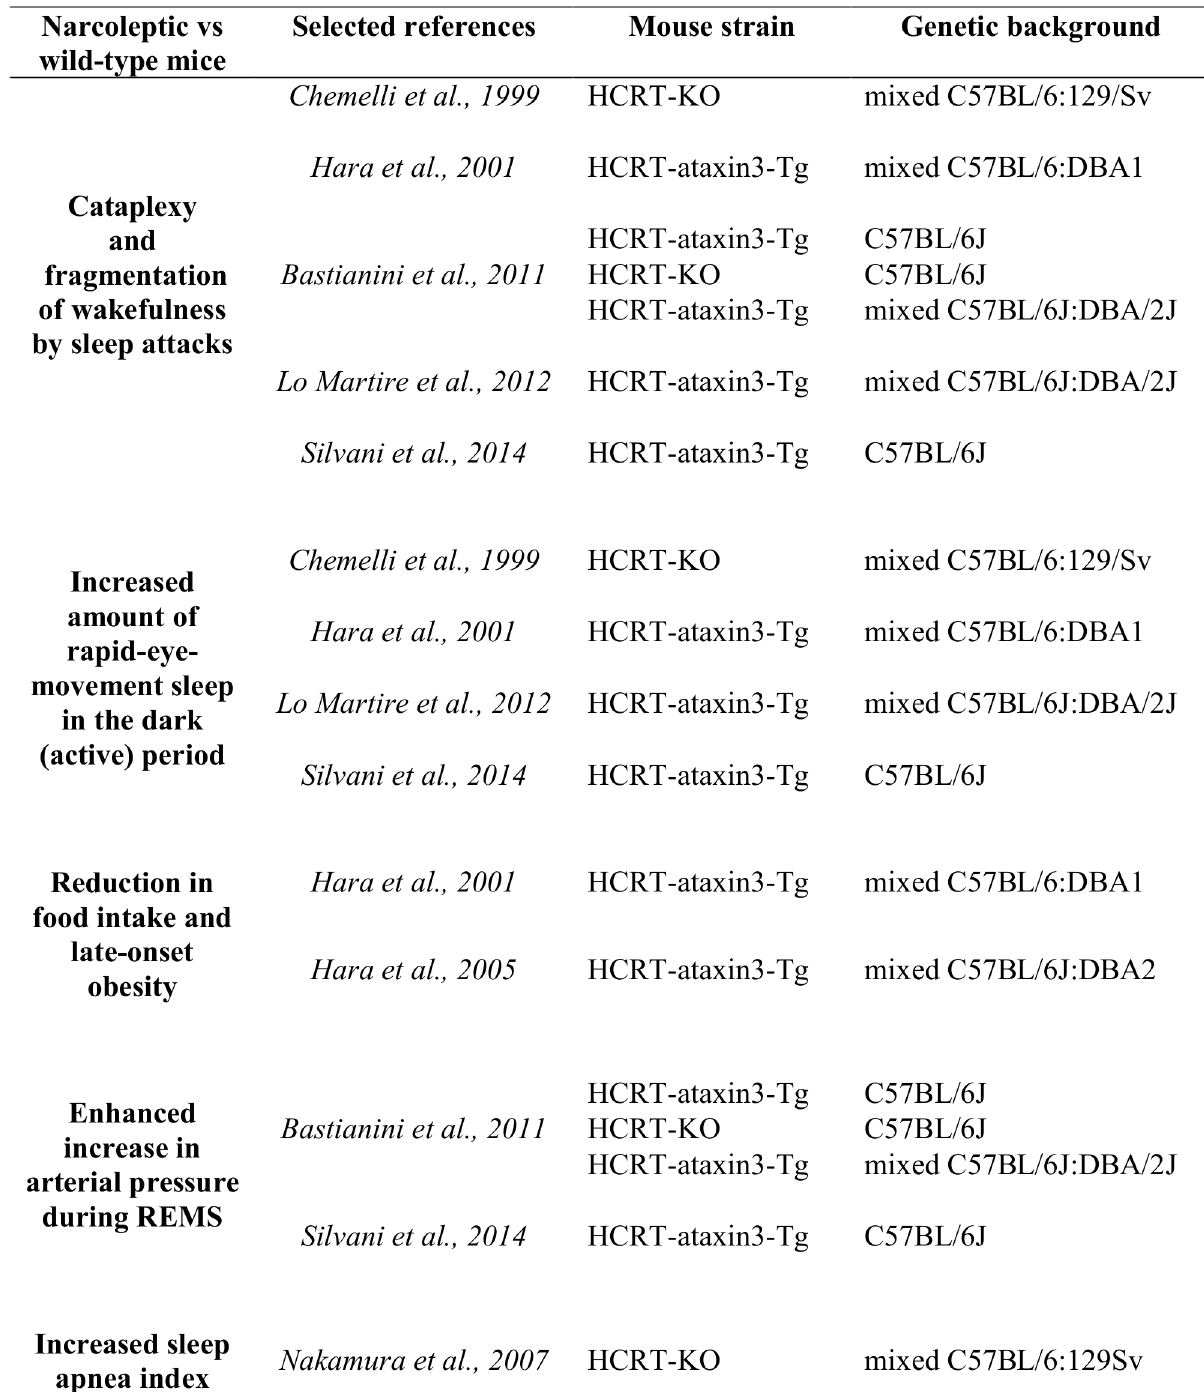
Fig 1. Narcolepsy characteristics described in different strains of male genetically-engineered orexin-deficient mice. HCRT-ataxin3-Tg: mice hemizygous for a transgene (hypocretin-ataxin3) coding for a neurotoxin, which causes selective ablation of orexin neurons; HCRT-KO: hypocretin gene knock-out mice with congenital deficiency of